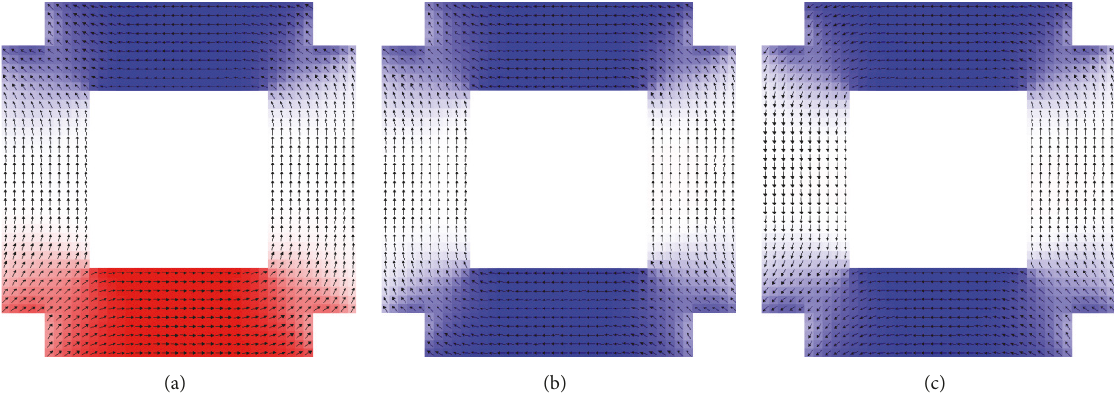
Figure 3: Possible magnetic states for not-too-large angles: horseshoe 1 (a), onion (b), and horseshoe 2 (c).